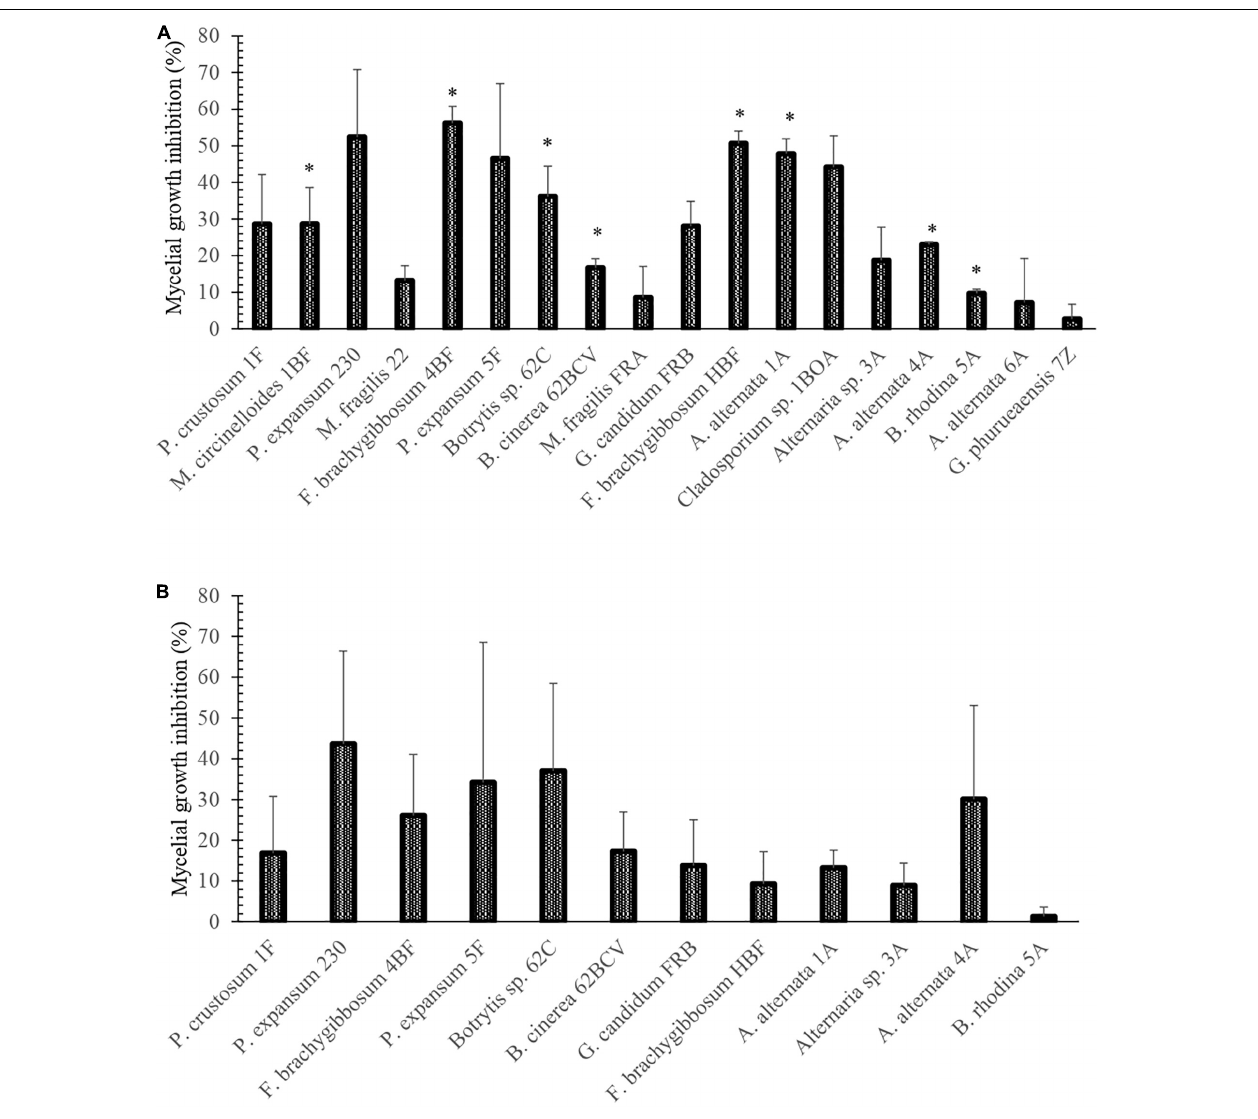
FIGURE 3 | Percentages of inhibition of fungi isolated from berries postharvest caused by (A) diffusible and (B) volatile compounds of the SER3 strain. The experiments were carried out independently three times. Bars represent mean ± SE. Asterisks indicate significant difference compared to the respective controls, using Student’s t -test ( p <